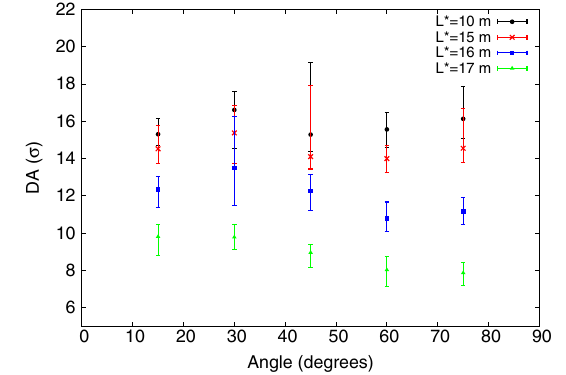
FIG. 16. Comparison of DA studies for different values of L (cid:1) . Cases with L (cid:1) ¼ 10 , 15, 16, 17 m with a fixed β (cid:1) ¼ 10 cm are shown. Figure 16 represents the comparison between the cases L (cid:1) ¼ 10 , 15, 16 and 17 m. A small reduction of DA is